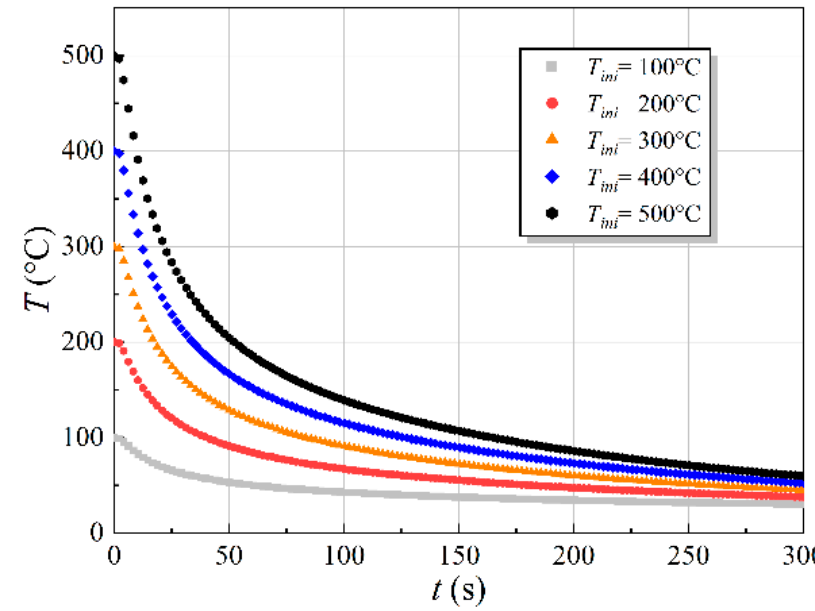
Figure 6. Measured temperature of the thermocouple.